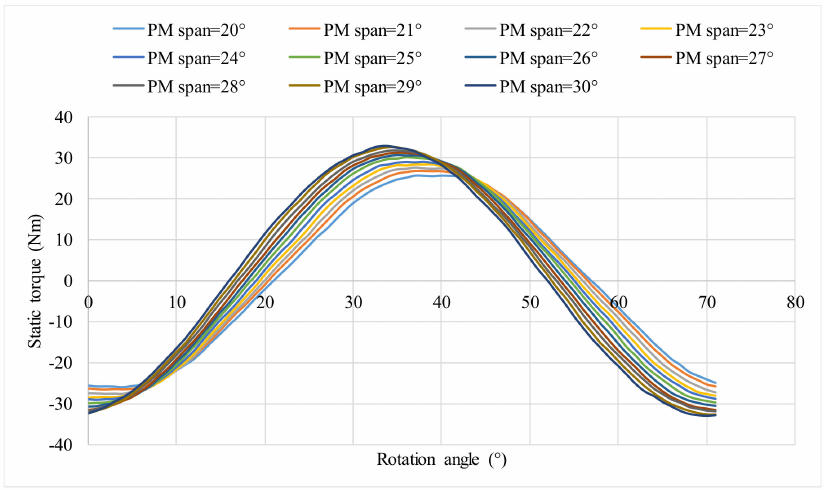
Figure 6. PM span influence on the torque size of the machine.